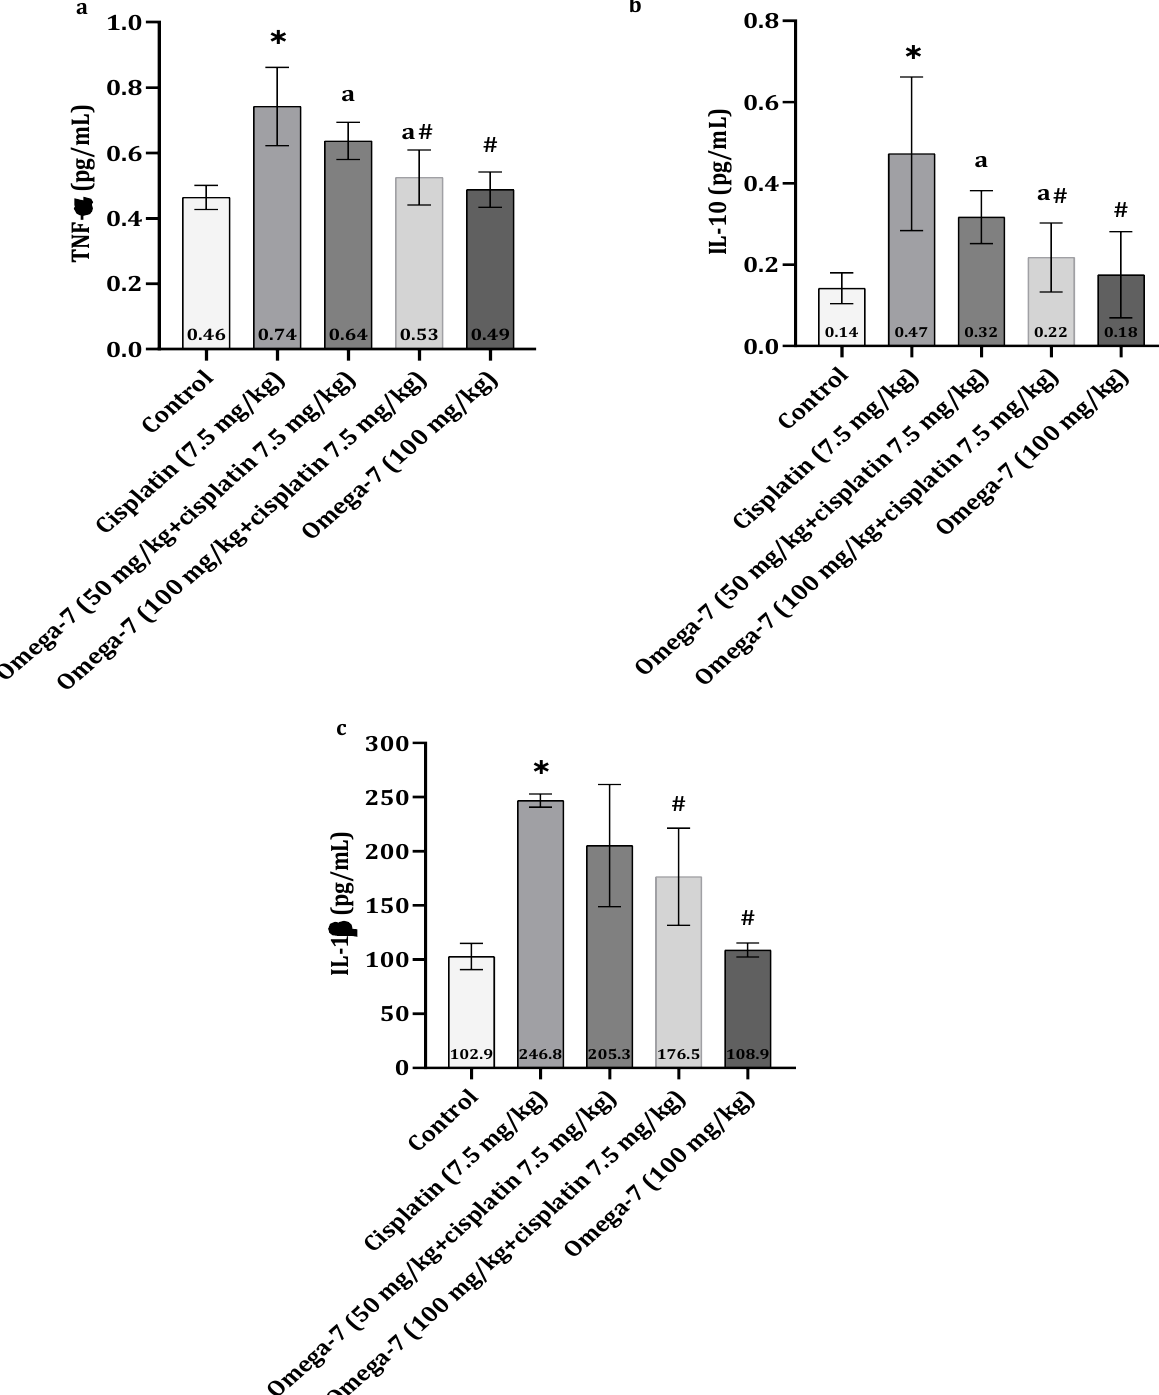
Figure 1. Effects of omega-7 on the activities of ( a ) serum tumor necrosis factor-alpha (TNF- α) pg/mL ( b ) interleuke (IL)- 1β (IL- 1β ), and ( c ) IL-10. The data are Mean±SD,n=6. * Indicates a significant difference when compared to the negative control group ( P < 0.05). # Indicates a significant difference when compared to the positive control (cisplatin group) ( P <